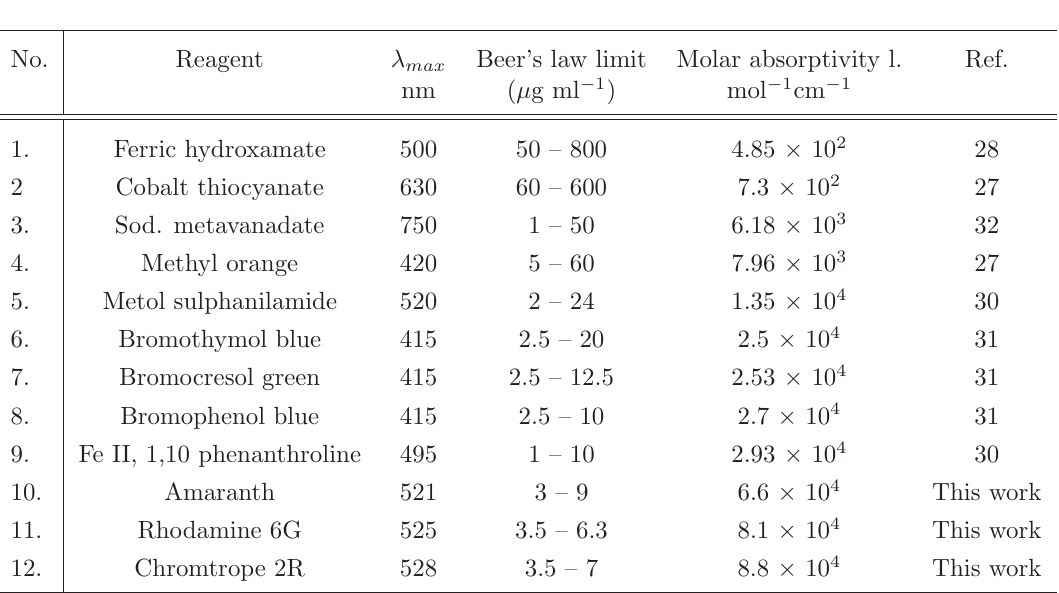
Table 4 Comparison of reagents of previously reported spectrophotometric methods with that of the proposed methods for